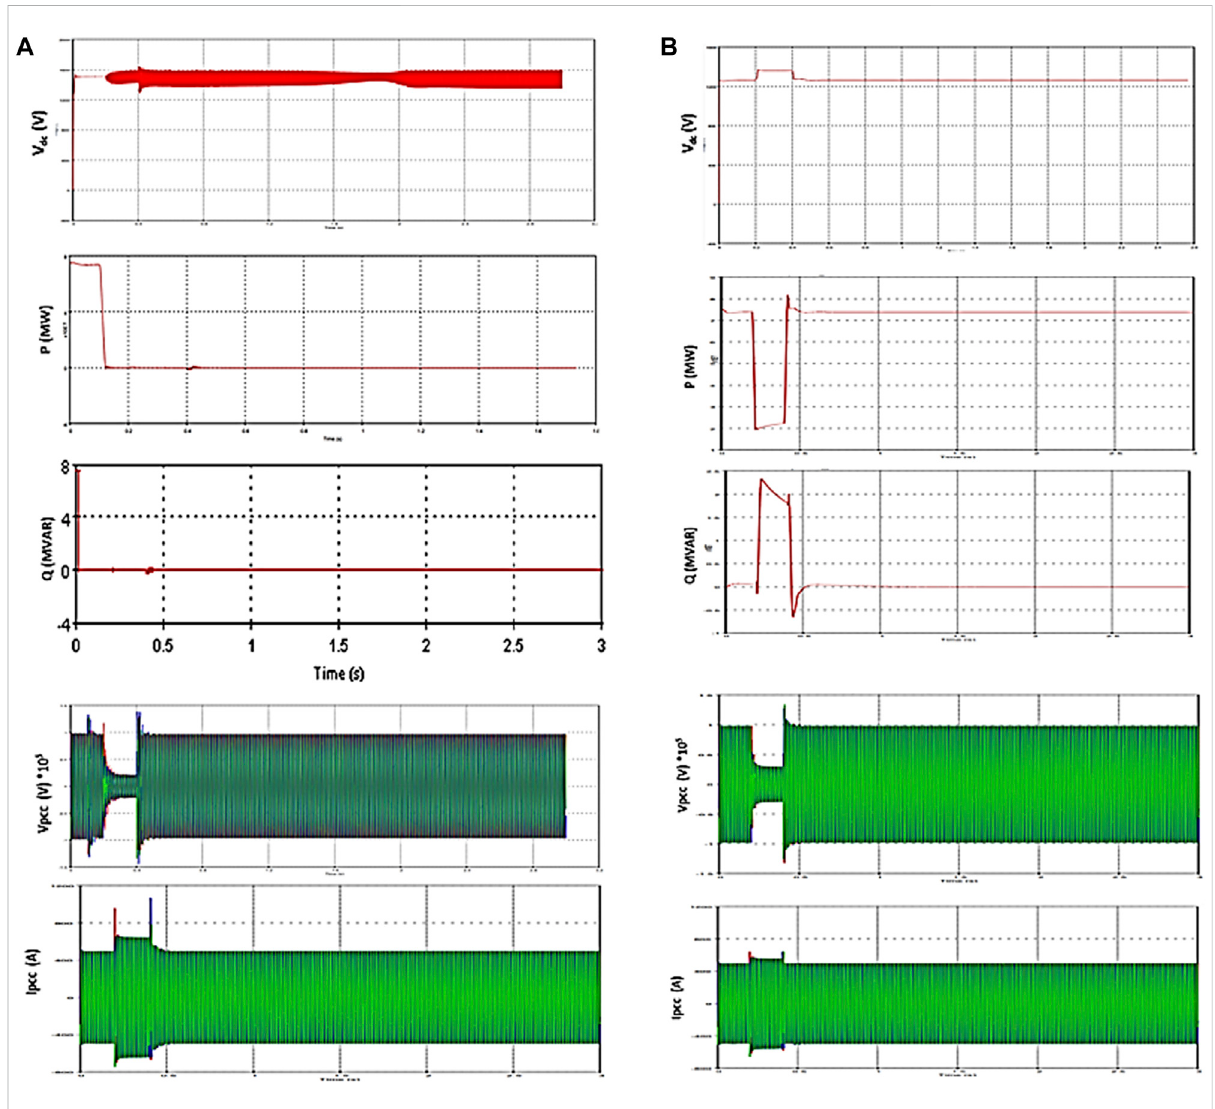
FIGURE 3 Performance of system during grid faults: (A) without control and (B) proposed